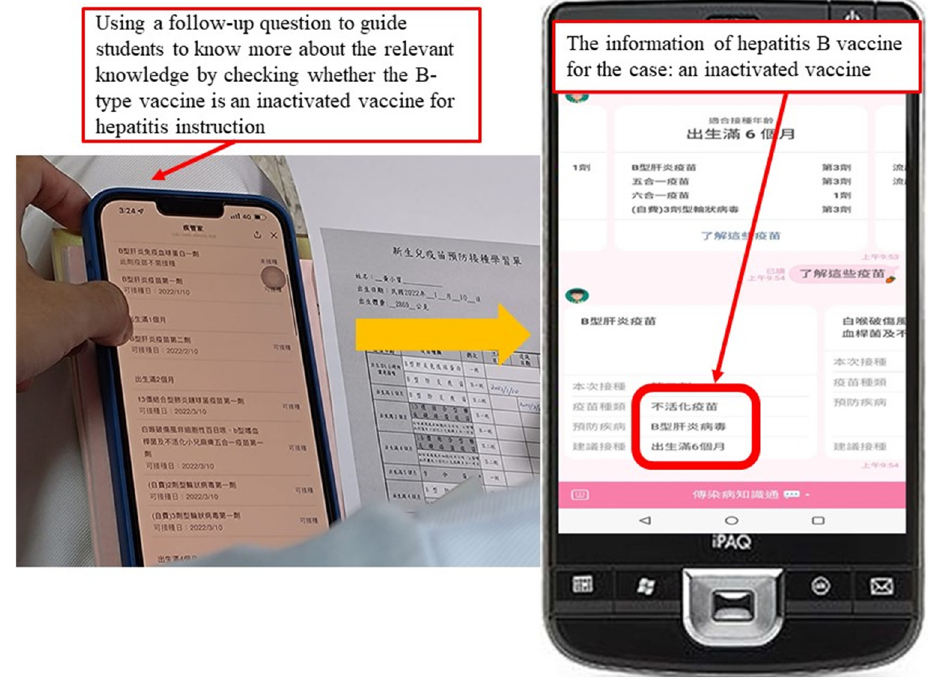
Figure 4. Example of the Interaction stage.